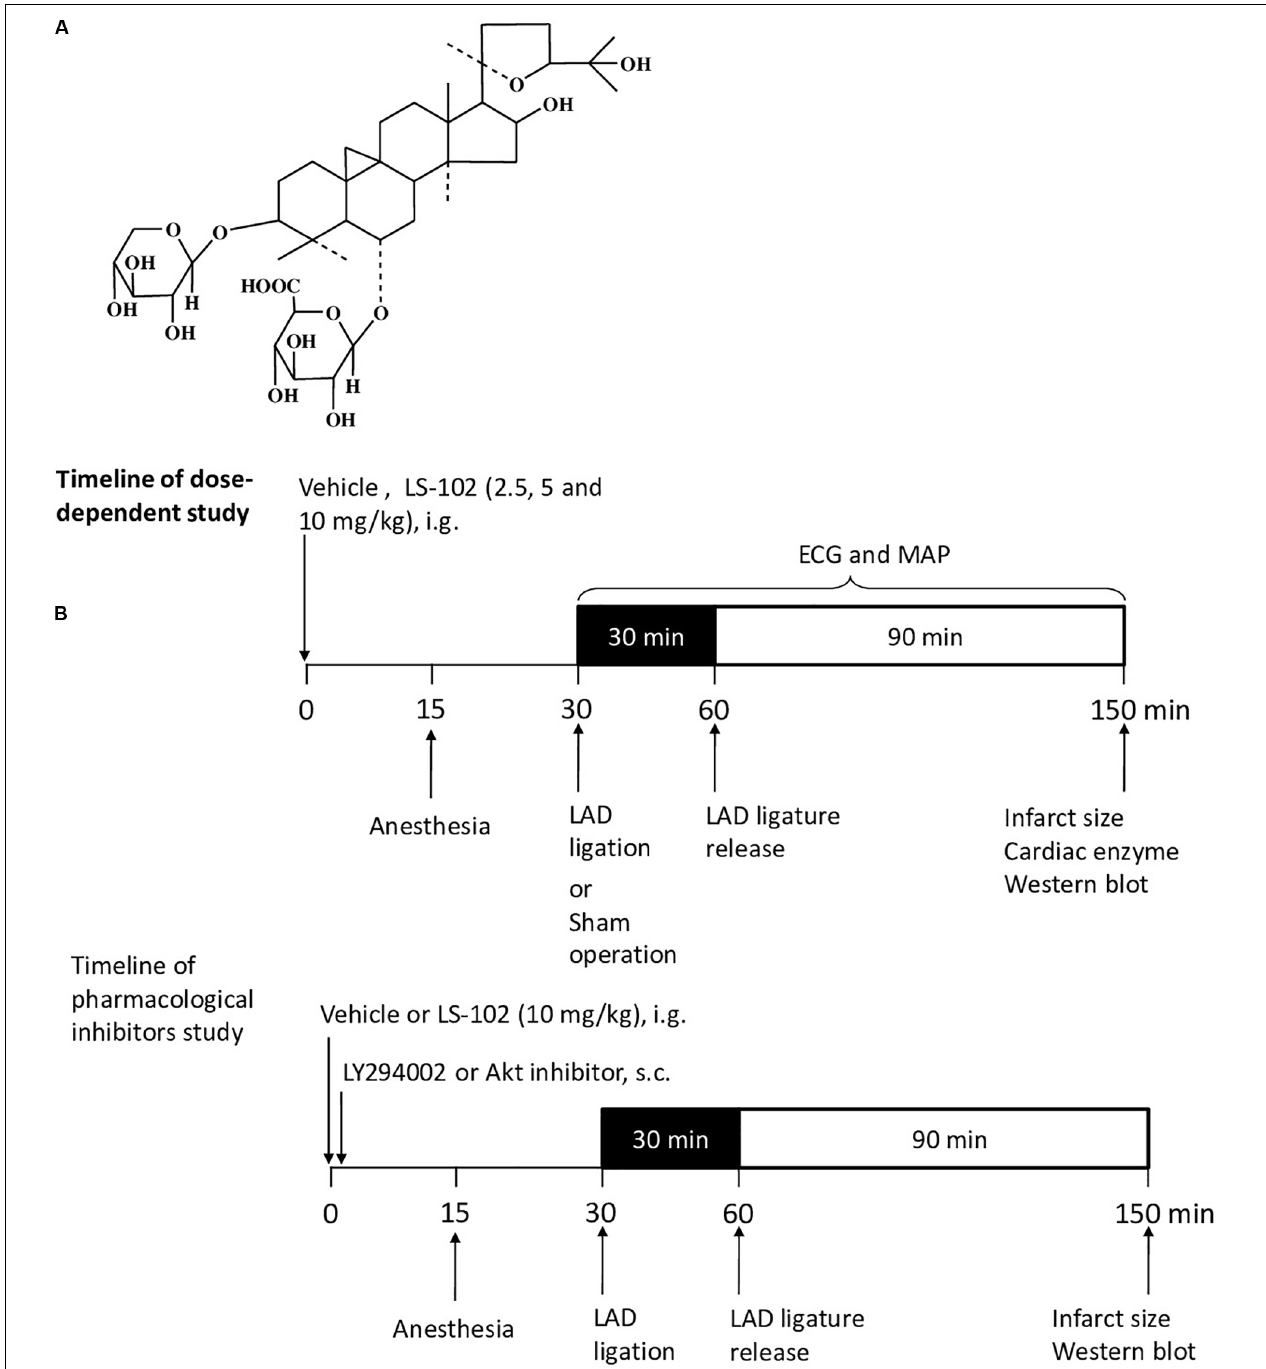
FIGURE 1 | Outline of the experimental protocol to assess the cardioprotective effect of LS-102 on the model of myocardial I/R-induced rat injury. (A) Molecular structure of LS-102. (B) Protocols of dose-dependent study and pharmacological inhibitors study. Rats were pretreated with vehicle or LS-102, followed by 30 min of ischemia and then 90 min of reperfusion. Rat hearts were collected for TTC and H&E staining, the rat serum samples were also collected to detect the activities of CK and LDH.